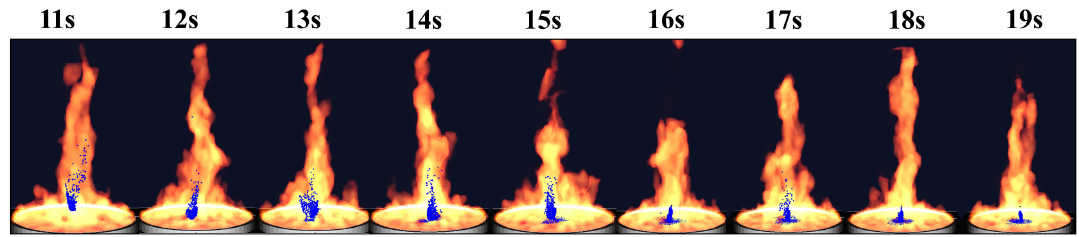
Figure 4. Effect of variable extinction coefficient on the temperature at the ( A ) fuel surface and ( B ) temperature at z = 4.6 m, DPS = 10,000, and Rosin-Rammler distribution with a median diameter of 275 µm.